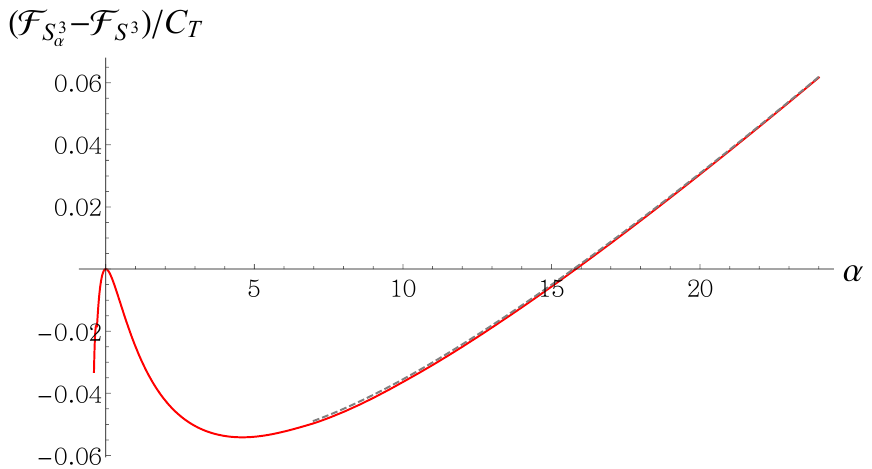
Figure 2 . The free energy for a free Dirac fermion on the squashed S 3 as a function of the squashing parameter (cid:11) . The round sphere is not a global maximum, as the free energy grows unbounded after reaching a local minimum for (cid:11) ’ 4 : 6228. For large enough (cid:11) , the free energy is given by min Equation (3.21) [23], which we also plot (gray dashed